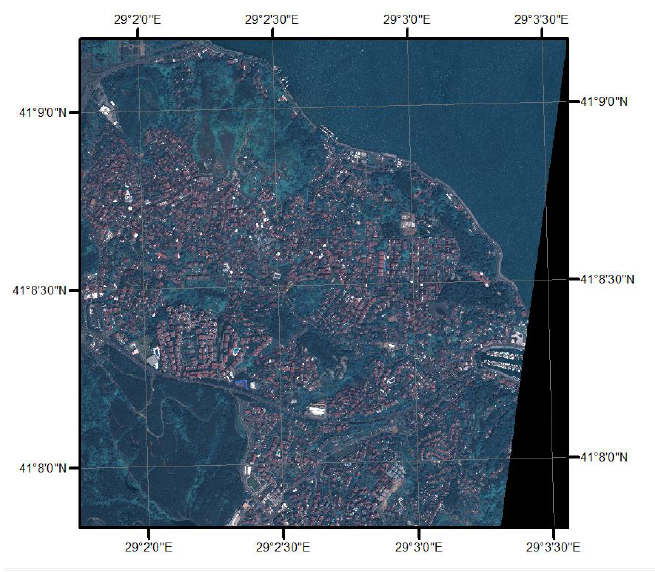
Figure 2. Test site from Istanbul on Worldview-4 VHR satellite